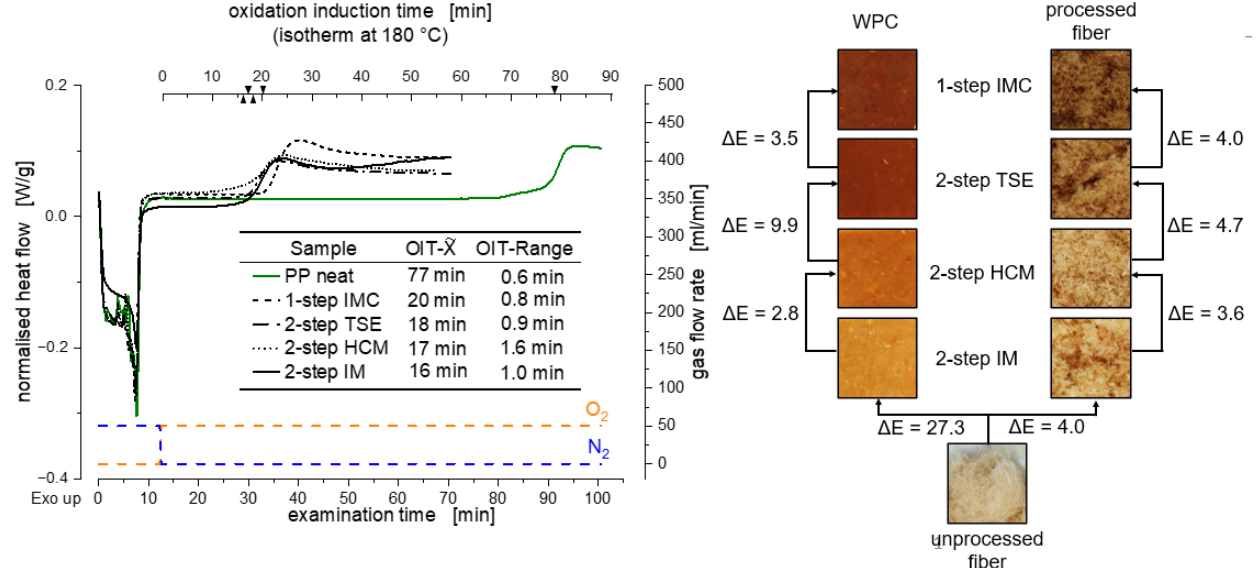
Figure 4. Comparison of the oxidation induction time of each individual melting process (measured on the WPC part) and the temperature effect during the processes shown on exemplary curve progressions ( left ); photographs of the tensile bars and extracted fibers show the discoloration due to processing quantified by the color deviation ( right ), n = 3; 𝑋̃ and Range .